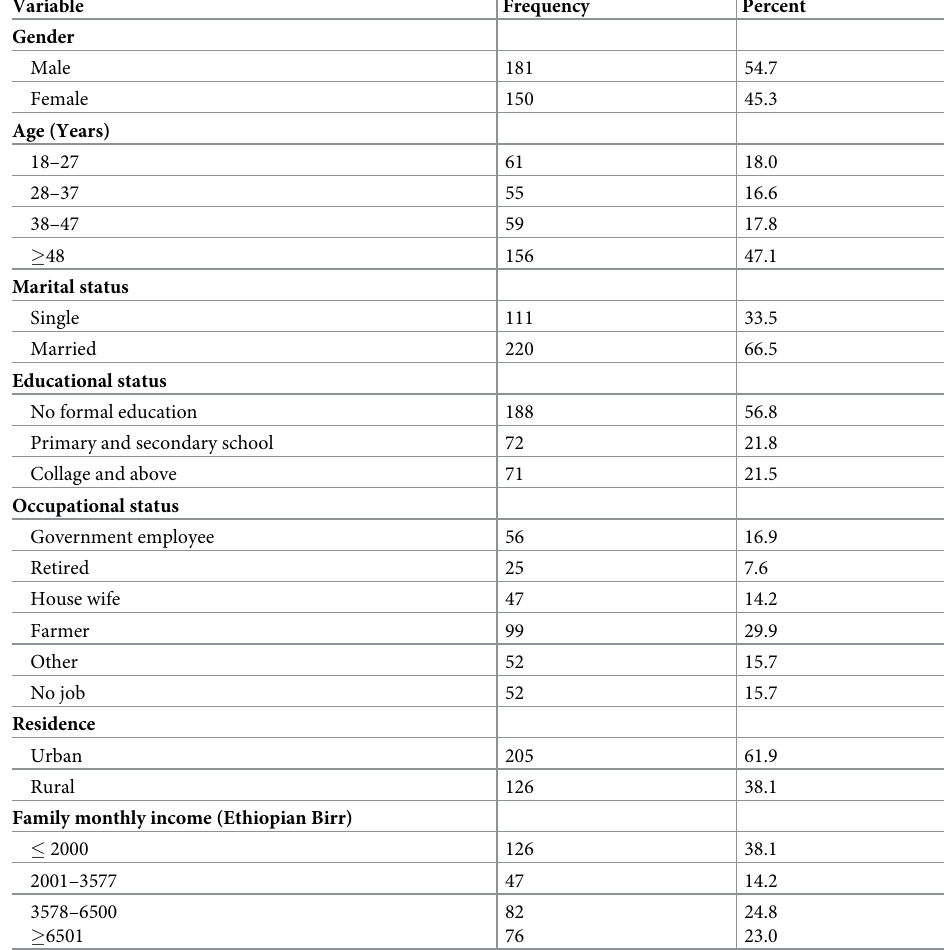
Table 1. Socio-demographic and economic characteristics of study participants at Debre Tabor General Hospital, Northwest Ethiopia, 2020 (n = 331). Variable